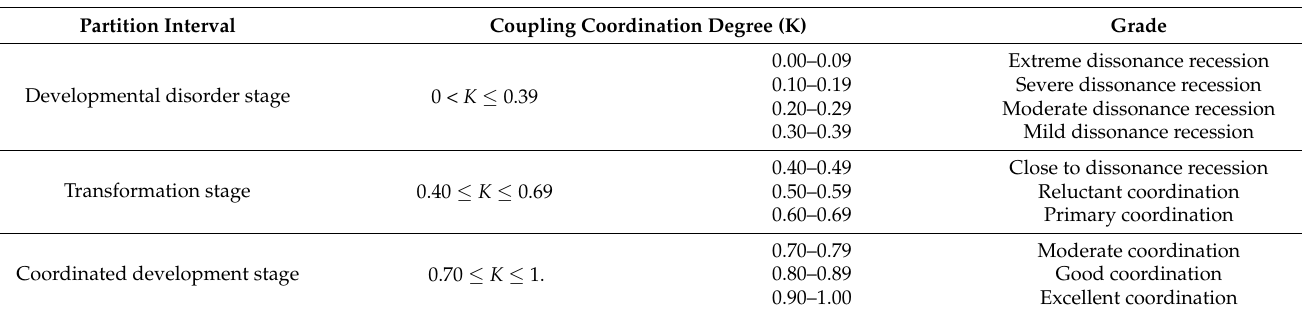
Table 5. Discrimination criteria for the coupling coordination type.